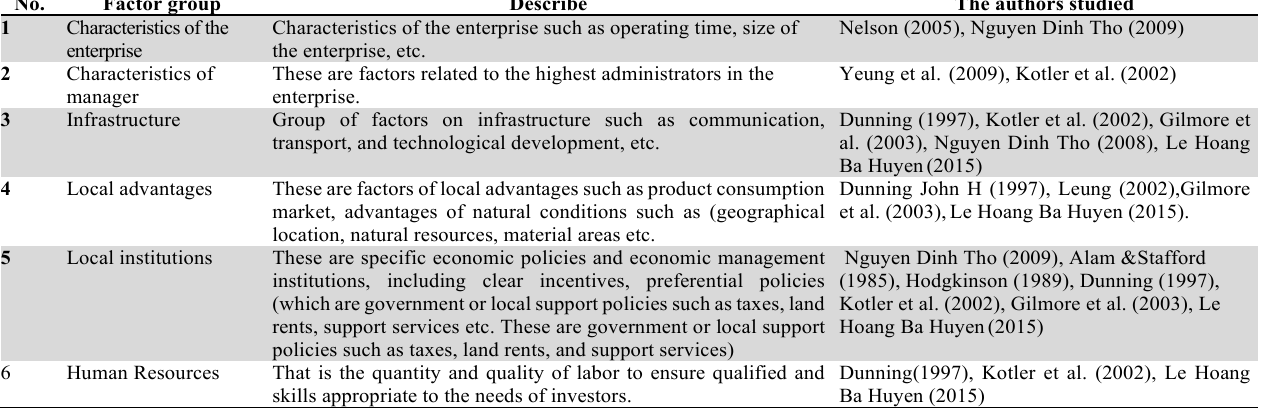
Summary of influencing factors to attract investment capital into industrial